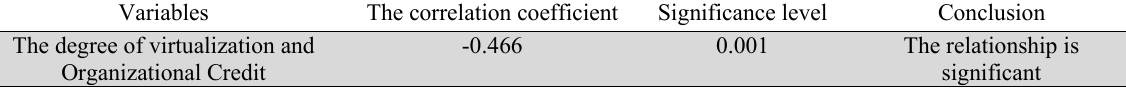
Variables The correlation coefficient Significance level Conclusion The degree of virtualization and -0.466 0.001 The relationship is Organizational Credit